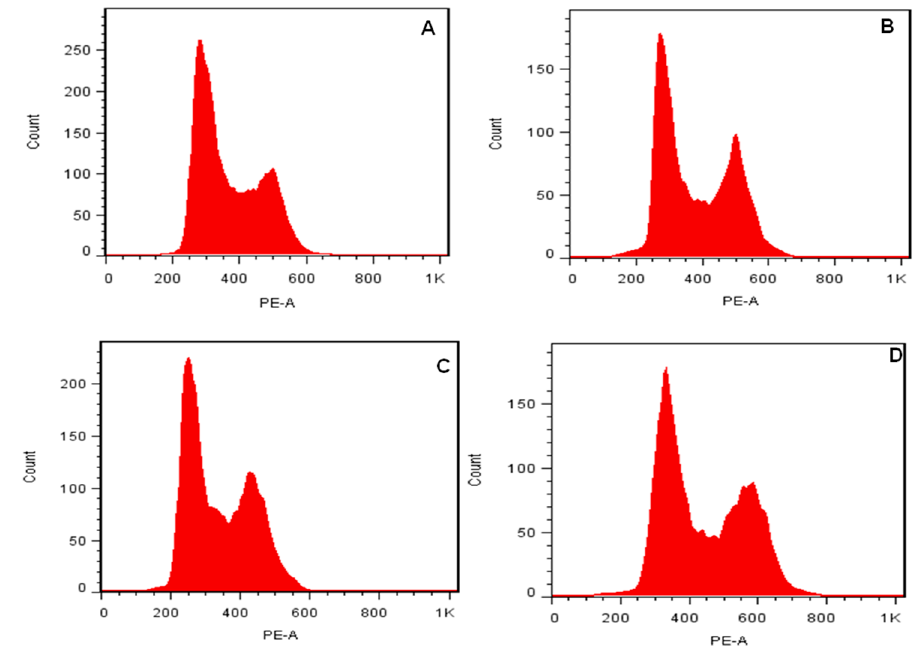
Figure 5. Cell cycle analysis of MDA-MB-231 cells after exposure to OHR-1 , -2 , -3 and -5 for 24 h. After treatment, cells were fixed in 70% ethanol and then analyzed by flow cytometry distribution by propidium iodide/DNA content staining. ( A ) Solvent control- treated MDA-MB-231 cells; ( B1-E1 ) Cell cycle analysis of cells treated with OHR-1 (7.5 μ M), OHR-2 (2.5 μ M), OHR-3 (5 μ M) and OHR-5 (7.5 μ M) for; ( B2-E2 ): Cell cycle analysis of cells treated with OHR-1 (15 μ M), OHR-2 (5 μ M), OHR-3 (10 μ M), OHR-5 (15 μ M) treated MDA-MB-231 cells. ( F ) Cell cycle analysis of MDA-MB-231 cells treated with OHR-1 , -2 , -3 and -5 measured by flow cytometry. * p < 0.05 vs . vehicle